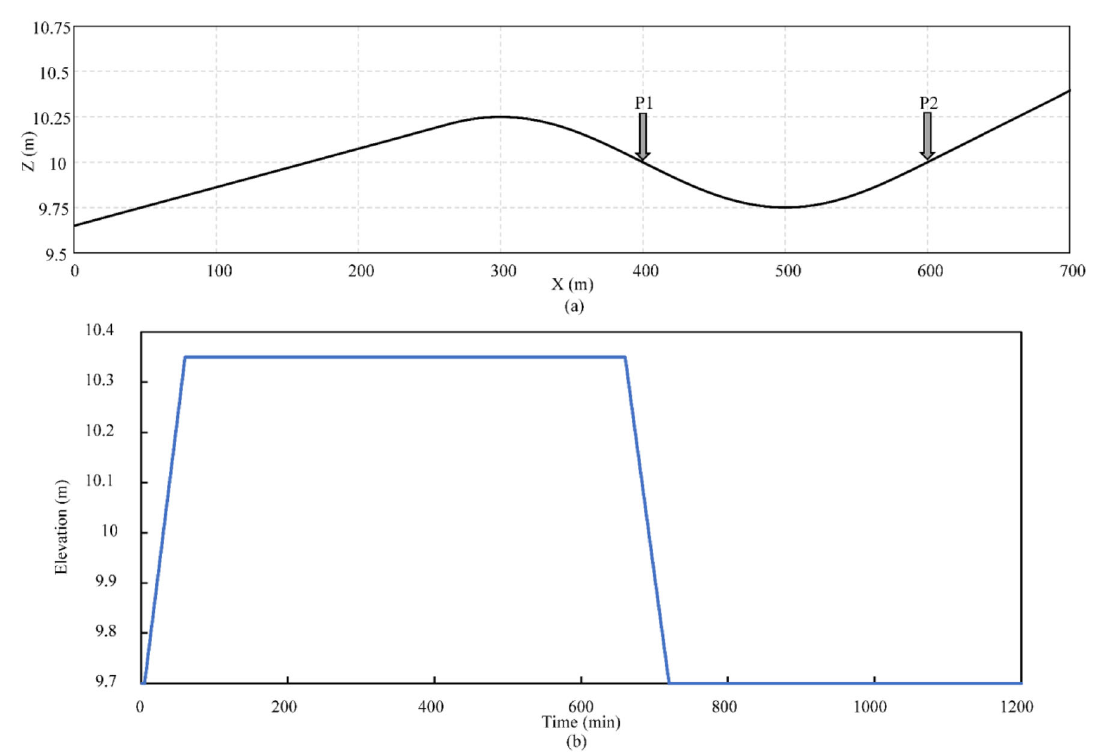
Fig. 3 Diagram of the flooding test of a disconnected water body a and the water level boundary condition at x = 0 m